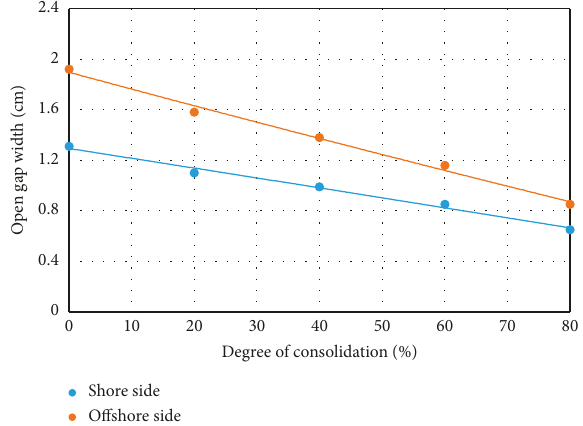
Figure 19: Variation rules for open gap of the empty box wing wall and sluice box culvert.